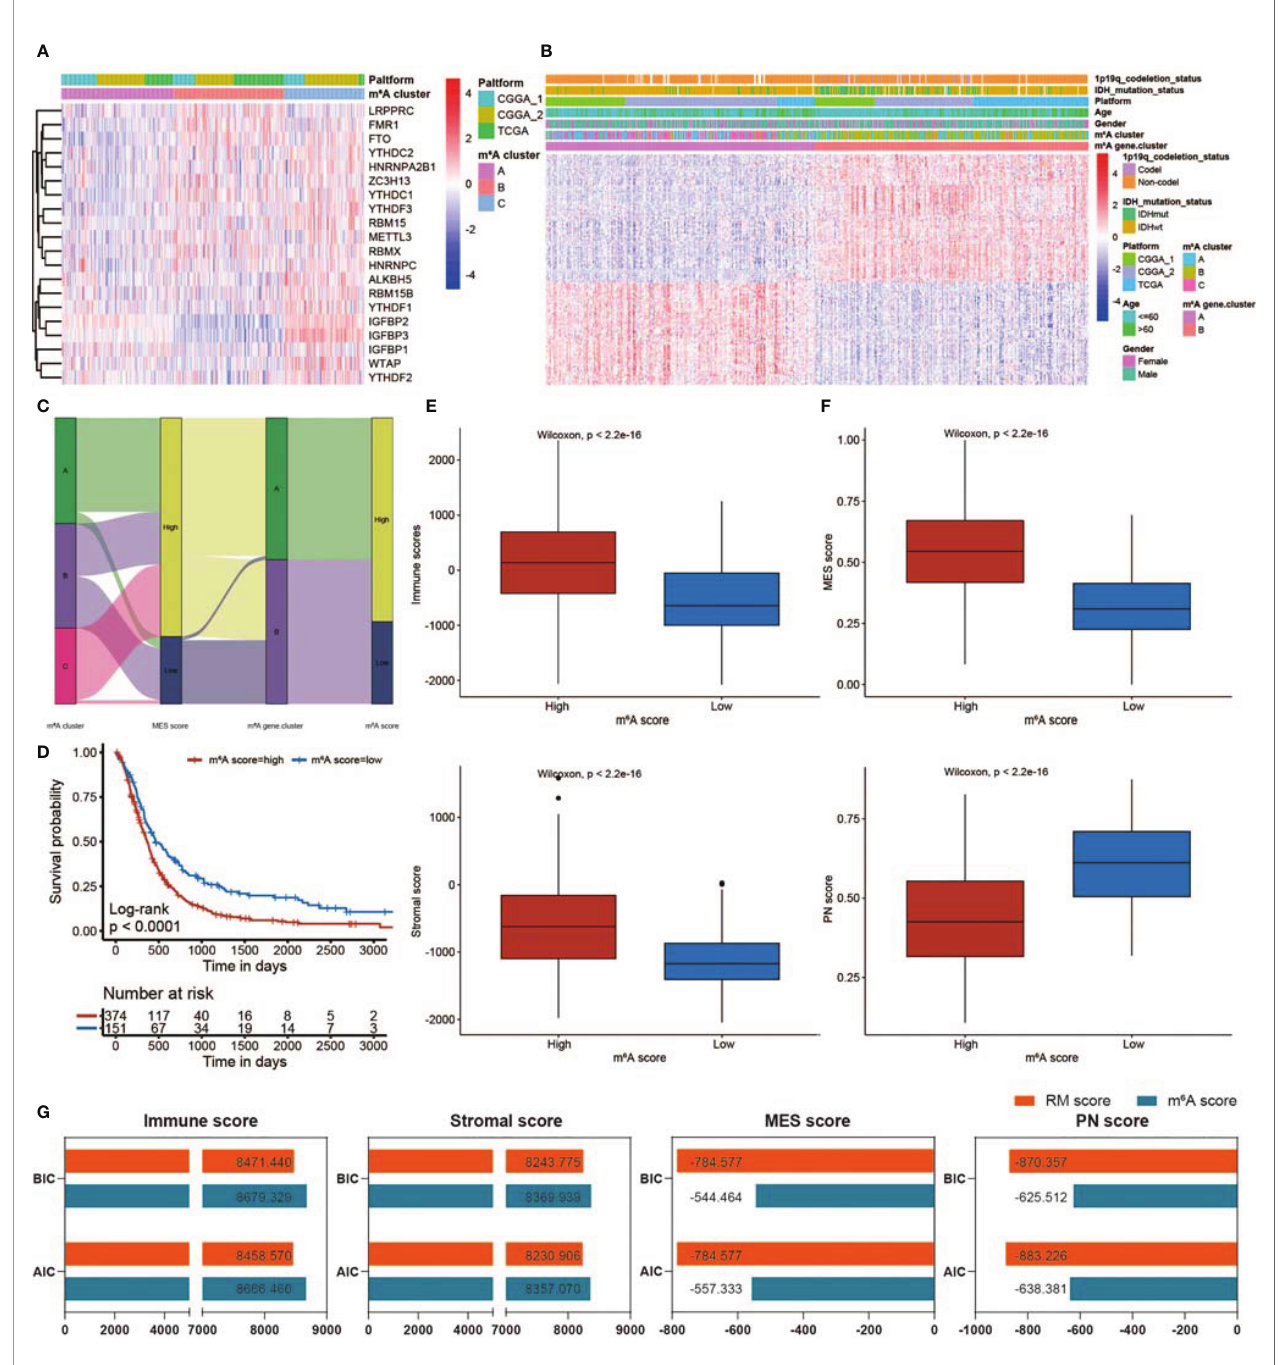
FIGURE 9 | Construction of the m 6 A score and comparison of the m 6 A and RM scores. (A) Heatmap showing unsupervised clustering for 20 m 6 A RNA modi fi cation genes in 539 GBM patients. Each column represents patients, and each row represents an m 6 A RNA modi fi cation regulator. (B) Unsupervised clustering of 172 DEGs dividing patients into two m 6 A gene.clusters, termed m 6 A gene.cluster_1 and m 6 A gene.cluster_2. The m 6 A gene.cluster, m 6 A cluster, sex, age, platform, IDH status, and 1p19q status were applied for patient annotation. (C) Sankey diagram showing the distribution of m 6 A RNA modi fi cation patterns, MES scores, m 6 A gene.clusters, and m 6 A scores. (D) KM curve showing survival analysis results of the high m 6 A score and low m 6 A score patient groups. (E) Differences in immune/stromal scores among GBMs with low m 6 A scores and high m 6 A scores. (F) Differences in MES/PN scores among GBMs with low m 6 A scores and high m 6 A scores. (G) Comparison of RM and m 6 A scores using BIC and AIC